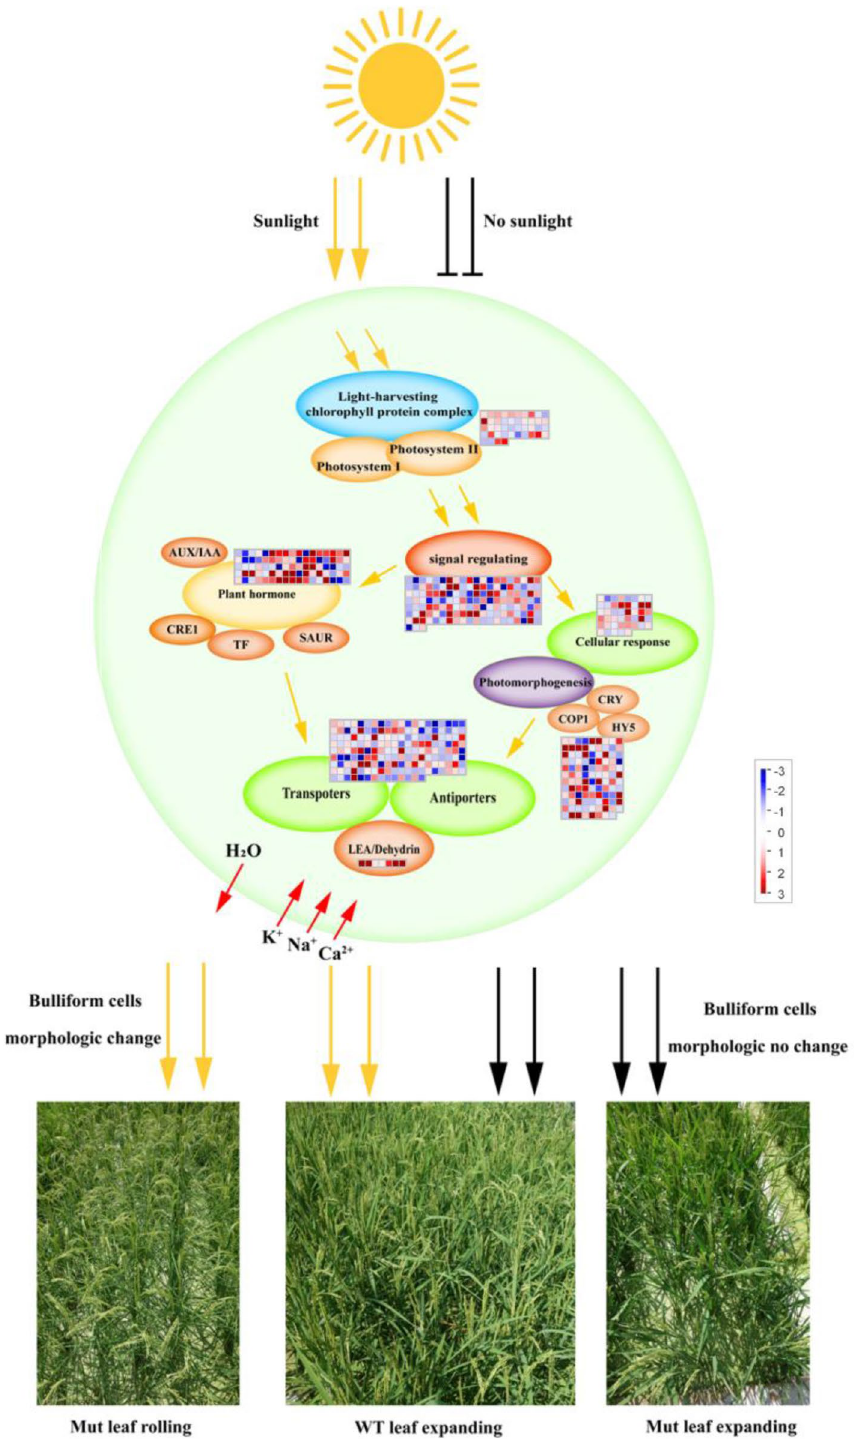
Figure 8. A working model explaining the rapid and dynamic leaf rolling in the OsRUS1-OX in response to sunlight. Note: The expressions of some genes in mesophyll cells (green cycle) are regulated due to the overexpression of OsRUS1-GFP . The transgenic plants become more sensitive to sunlight. The sunlight will trigger the pathway to cause the leaf rolling of OsRUS1-OX . The WT is not as sensitive to sunlight as OsRUS1-OX , and the pathway will not be triggered under the same conditions. If the sunlight is shaded, although the pathway is still there, it is not activated, and the bulliform cells of OsRUS1-OX will be refilled with water to cause leaf